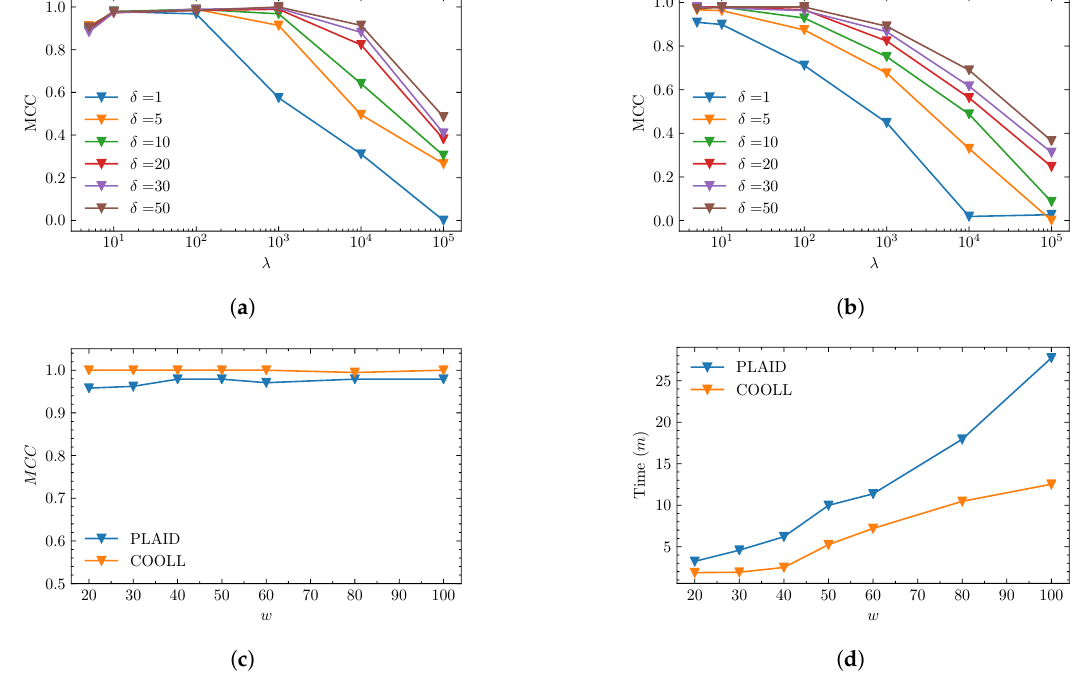
Figure 6. Impact of WRG parameters in the measured performance: ( a ) Impact of λ for different value of δ on the COOLL dataset; ( b ) Impact of λ for different value of δ on the PLAID dataset; ( c ) The relationship between w and MCC score for COOLL and PLAID dataset; ( d ) The relationship between w and training time on the PLAID and COOLL